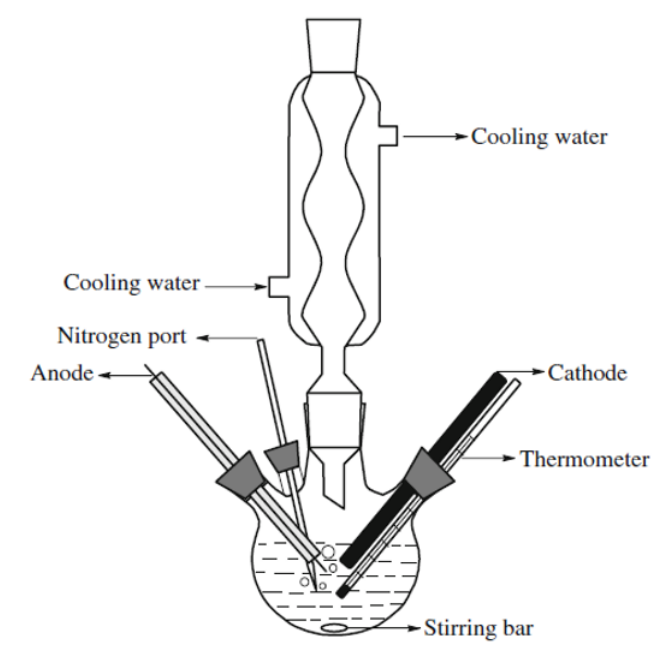
Figure 2. The experimental setup for polymerization by GDEP (Adapted from [39]).